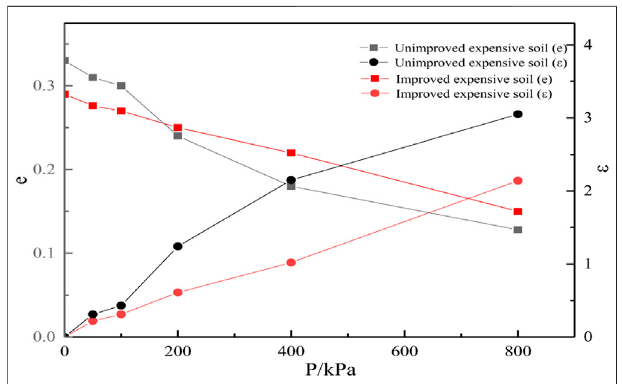
FIGURE 1 | e-p curves and ε -p curves of expansive